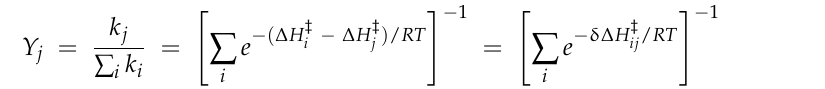
δ E dist (kJ/mol)